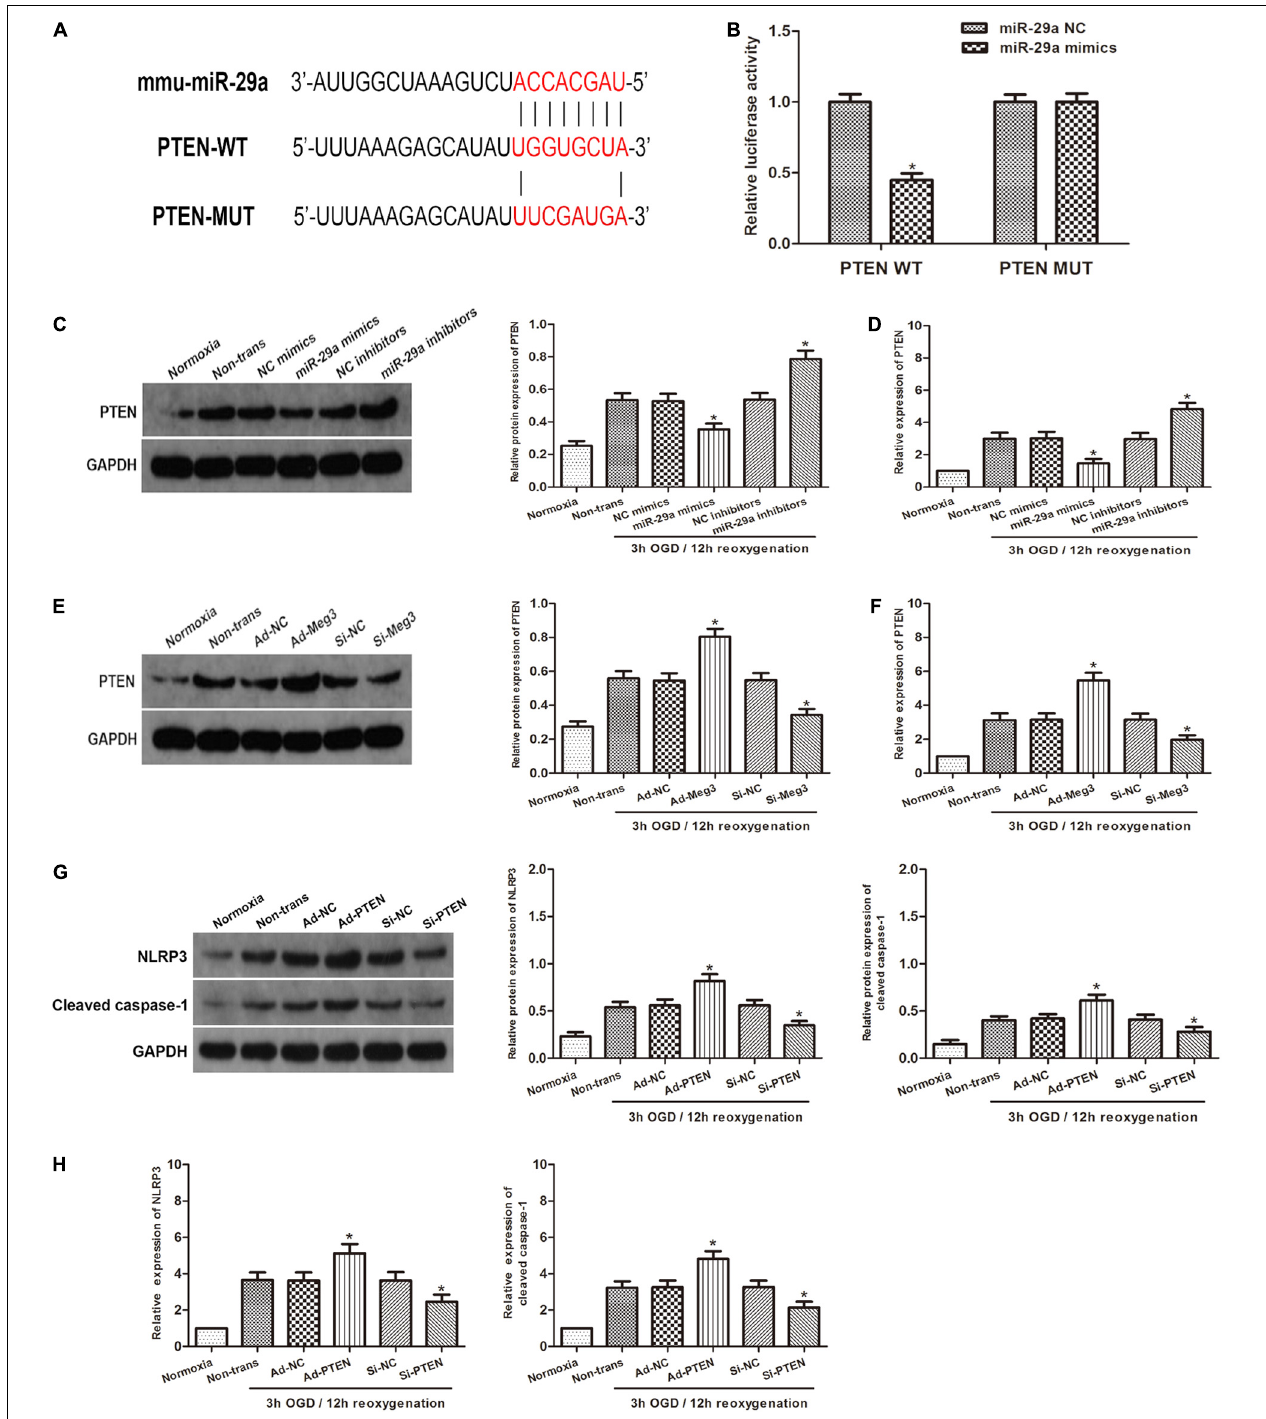
FIGURE 4 | PTEN is the target gene of miR-29a and is regulated by MEG3. (A) Prediction of miR-29a binding sites in the 3 (cid:48) UTR of PTEN (PTEN-WT) and its mutant sequence (PTEN-Mut). (B) A dual-luciferase reporter assay was executed to measure luciferase activity in cells cotransfected with miR-29a mimic and PTEN-WT or PTEN-Mut. (C,D) PTEN protein and mRNA expression of cells transfected with miR-29a mimic or miR-29a inhibitor under normoxia or 3 h/12 h OGD/R treatment. (E,F) PTEN protein and mRNA expression of cells transfected with ad-MEG3 or si-MEG3 under normoxia or 3 h/12 h OGD/R treatment. (G,H) NLRP3 and cleaved caspase-1 protein and mRNA expression of GC-1 cells transfected with ad-PTEN or si-PTEN under normoxia or 3 h/12 h OGD/R treatment. The data are presented as the mean ± S.E.M. n = 6. * p < 0.05 vs. control.